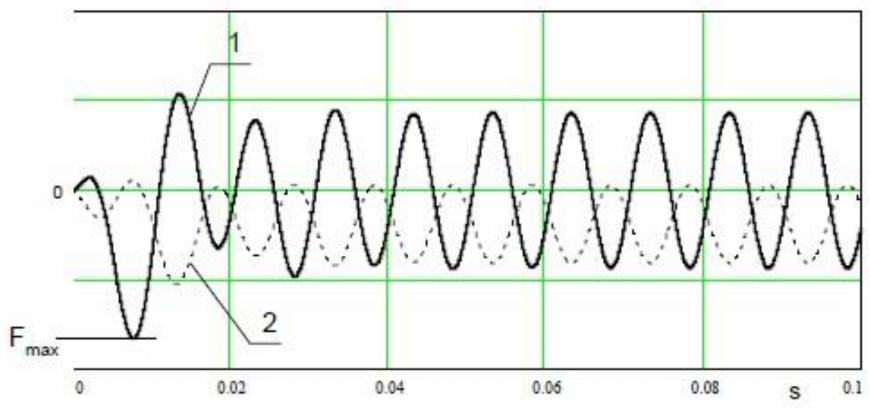
Figure 17. An example of the course of electrodynamic forces at a three-phase short circuit in a flat busbar system (the current in phase 1 runs as shown in Figure 15): 1—force acting on the middle rail L2, 2—force acting on the busbars L3 and L1